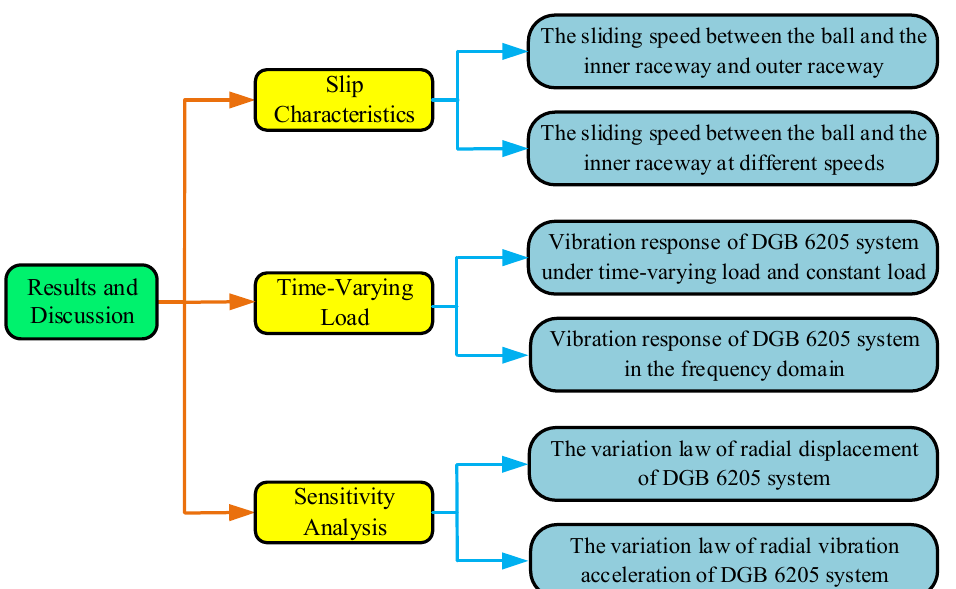
Figure 7. Flowchart of numerical simulation.